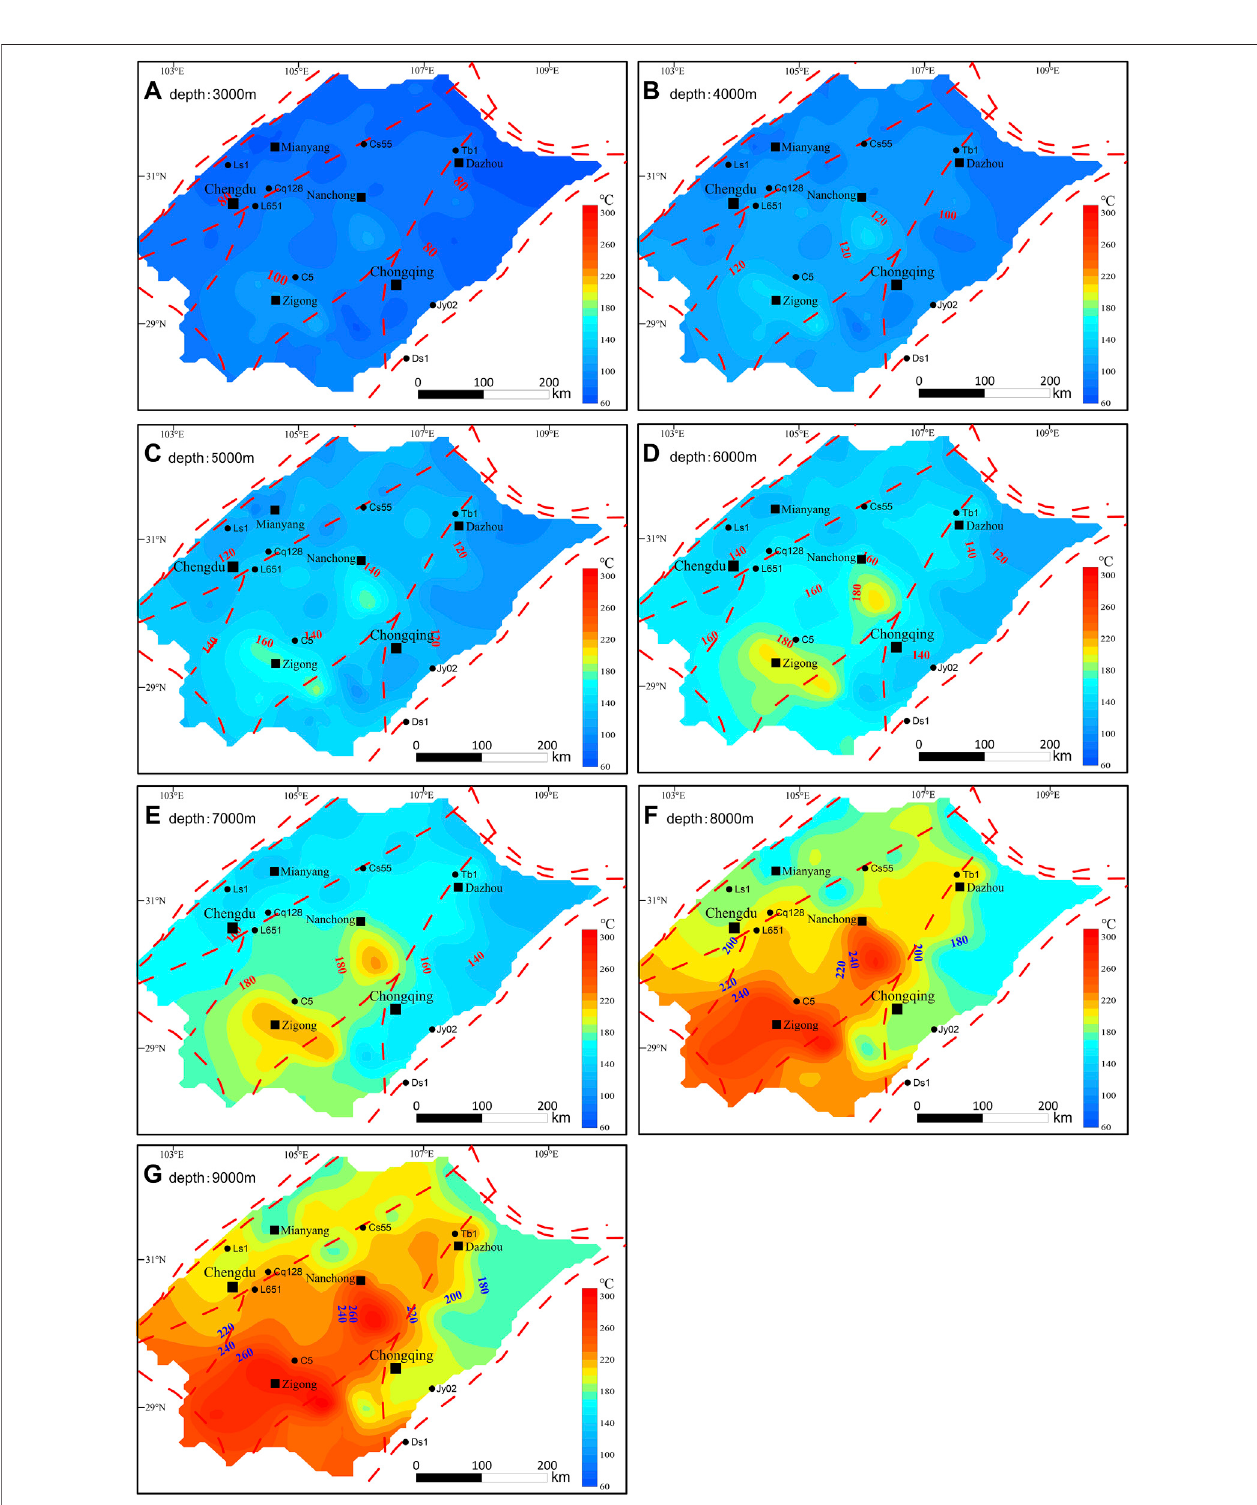
FIGURE 2 | Temperature distribution at the depth of 3,000 – 9000 m (A – G) in the Sichuan Basin. The red dash lines indicate the main faults which controlled the boundary of the basin and its surrounding mountains or divide the tectonic units inside the basin.